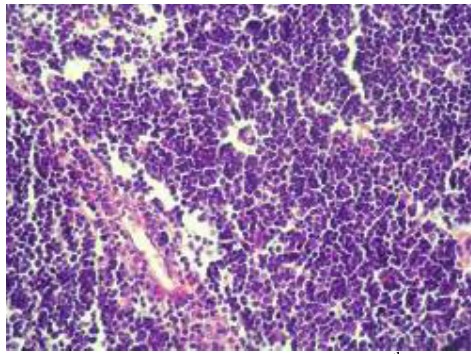
Fig. 4. Piglet thymus, control group, the 70 th day of test.